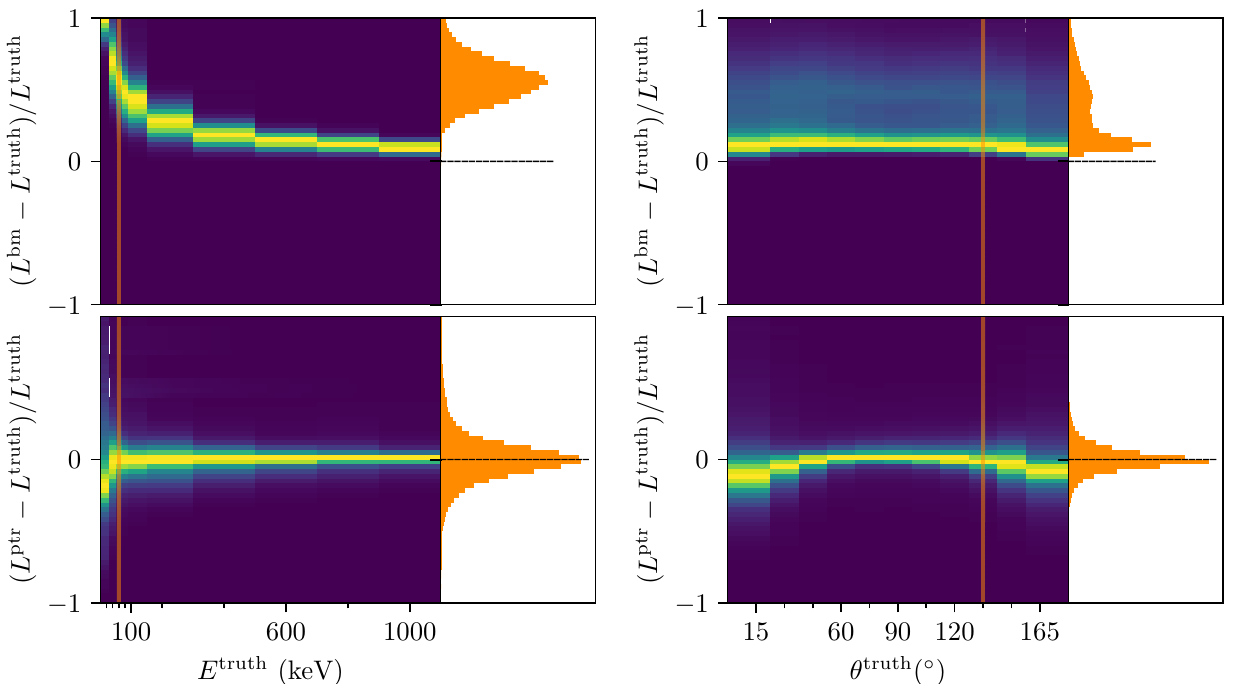
Fig. 9 The fractional error in the primary length L determination for benchmark (top) and ptr (bottom) methods, versus primary track energy (left) and polar angle (right). The color/shade indicates the num- ber of events in 2D bins, independently normalized in each column to